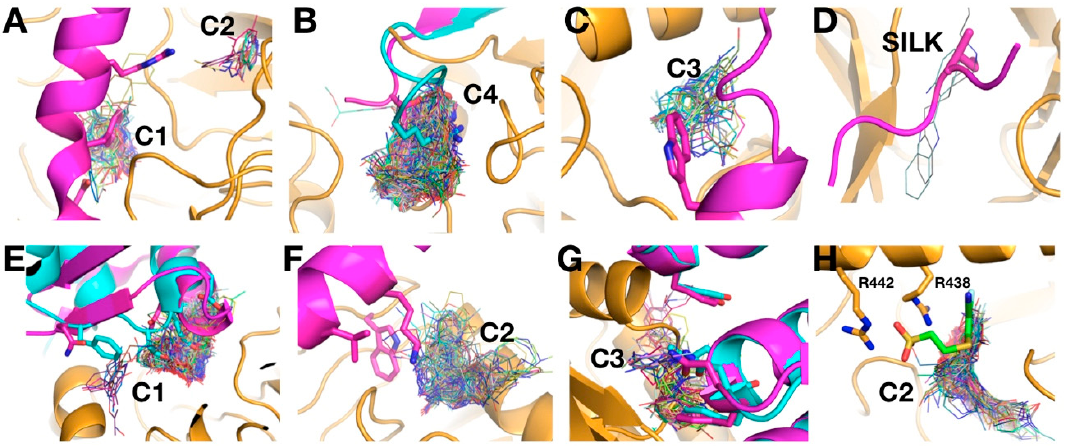
Figure 5. VSpipe blind docking ligand clusters overlap with protein–protein interaction sites. Blind docking clusters in GlcA, PphB, and NimT are shown on molecular models of the AfPPases (ribbon representation in orange and ligands shown as lines). The clusters match the protein interaction sites observed in the crystal structures of complexes of biological partners of the human homologues. Key binding residues are shown in sticks to emphasise the overlap with the ligand clusters identified by VSpipe. The GlcA model (orange) is superimposed to hPP1 interacting partners: ( A ) PPP1R2 (PDB: 2O8A, magenta) binds to the active site and overlaps with C1, while residues at the upper part of the helix are close to C2 in the acidic groove; ( B ) PPP1R15B (PDB: 4V0U, cyan) and PP1G (PDB: 6DNO, magenta) bind at the C-terminal groove and overlap with C4; ( C ) MYPT1, myosin-binding subunit (Protein phosphatase 1 regulatory subunit 12A) (PDB: 1S70) binds at the side pocket and a key tryptophan residue matches C3; ( D ) binding of PP1G at the SILK motif binding site matches with a low density cluster. The PphB model (orange) is superimposed to hPP2A interacting partners: ( E ) the PPME1, Protein phosphatase 2a specific methylesterase, (PDB: 3C5W, magenta) and LCMT-1, Leucine carboxyl methyltransferase, (PDB: 3P71, cyan) binding helices overlap with C1 at the active site; ( F ) SGOL1, Shugoshin-like 1, (PDB: 3FGA) binds to the side pocket and overlaps with C2; ( G ) PP2R1, Protein Phosphatase 2 regulatory subunit, (PDB: 5W0W, magenta) and PP2R1, Protein Phosphatase 2 regulatory subunit, (PDB: 2IE3, cyan) binds to the back of the protein (near P3) overlapping with C3. ( H ) NimT (orange) superimposed to the hCDC25B inhibitor (PDB: 4WH9, sticks in green and atom-type colouring) bound to the hCDK2 (human cyclin dependent kinase 2) kinase interaction site. The position of the inhibitor overlaps with C2. The side chains of the conserved R442 and R438 that participate in the binding are shown as